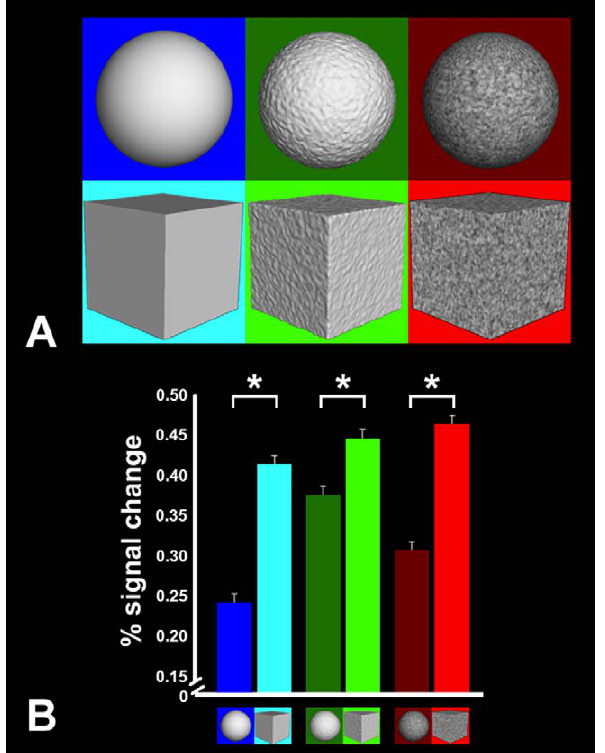
Figure 2. PPA responses to a range of computer-generated 3-D shapes. (A) In this experiment, the PPA responses were measured for ‘‘smooth,’’ ‘‘bumpy,’’ and ‘‘textured’’ versions of the sphere and cube (see icons). For each stimulus, the mean SF was estimated by the weighted averaging of SFs in the FFT power spectrum. This mean value was significantly greater in the three cubes, compared to the three spheres ( p , 0.005; paired t -test). (B) The fMRI responses to variations of the sphere and cube shapes in PPA. The PPA region of interest was defined functionally based on an independent place/face localizer (using naturalistic images; see Materials and Methods). An asterisk denotes a statistically significant difference ( F =14.45, p , 0.05; ANOVA, Sidak post-hoc test). Error bars indicate one standard error of the mean, based on a within-subjects ANOVA design. PPA showed a consistently higher fMRI response to cubes (which had a higher mean SF) than to spheres, with a significant linear trend of increased activity ( p , 0.001) from the addition of bumpy and textured patterns to the stimuli. These results suggest a sensitivity to spatial discontinuities (e.g., higher SFs) in PPA, as confirmed more directly in subsequent experiments.